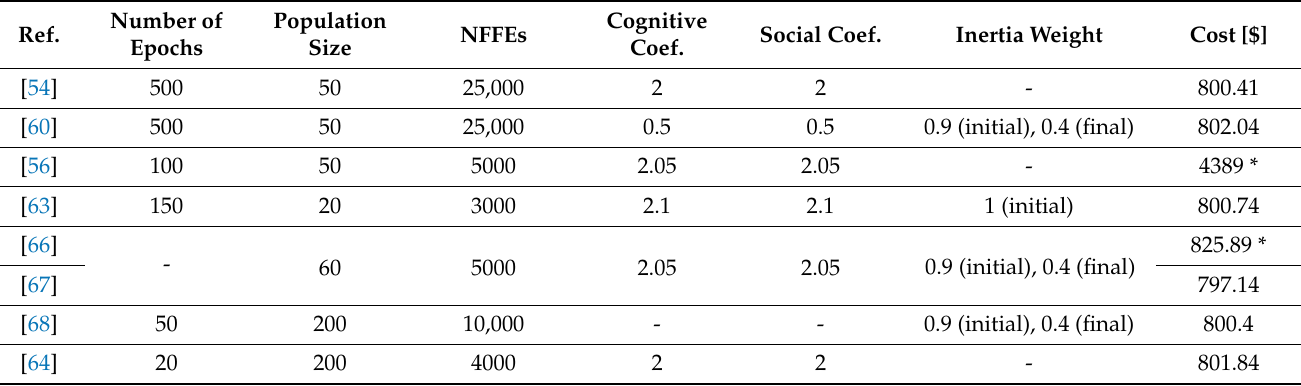
Table 6. Reported results of the reviewed PSO OPF works for the IEEE 30-bus network and cost minimization objective